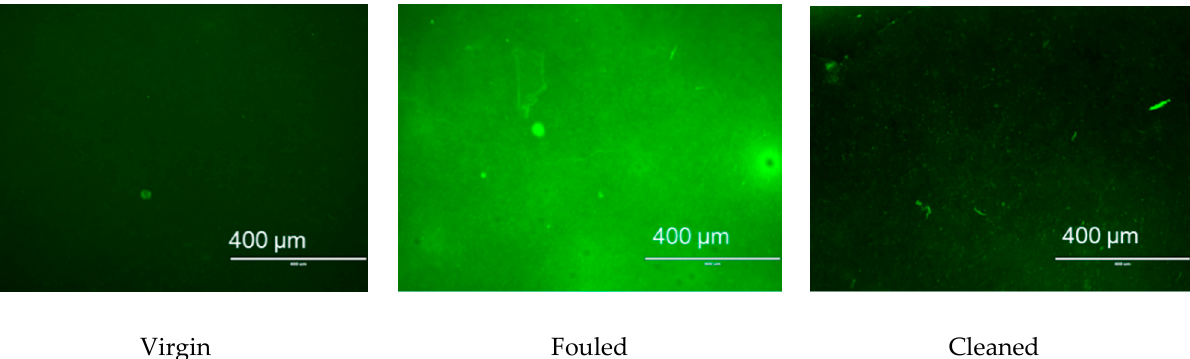
Figure 10. CSLM images of virgin, BSA fouled and cleaned ( left to right ) PANI/EG composite membranes (applied potentable 30. V) with scale bar of 400 µ